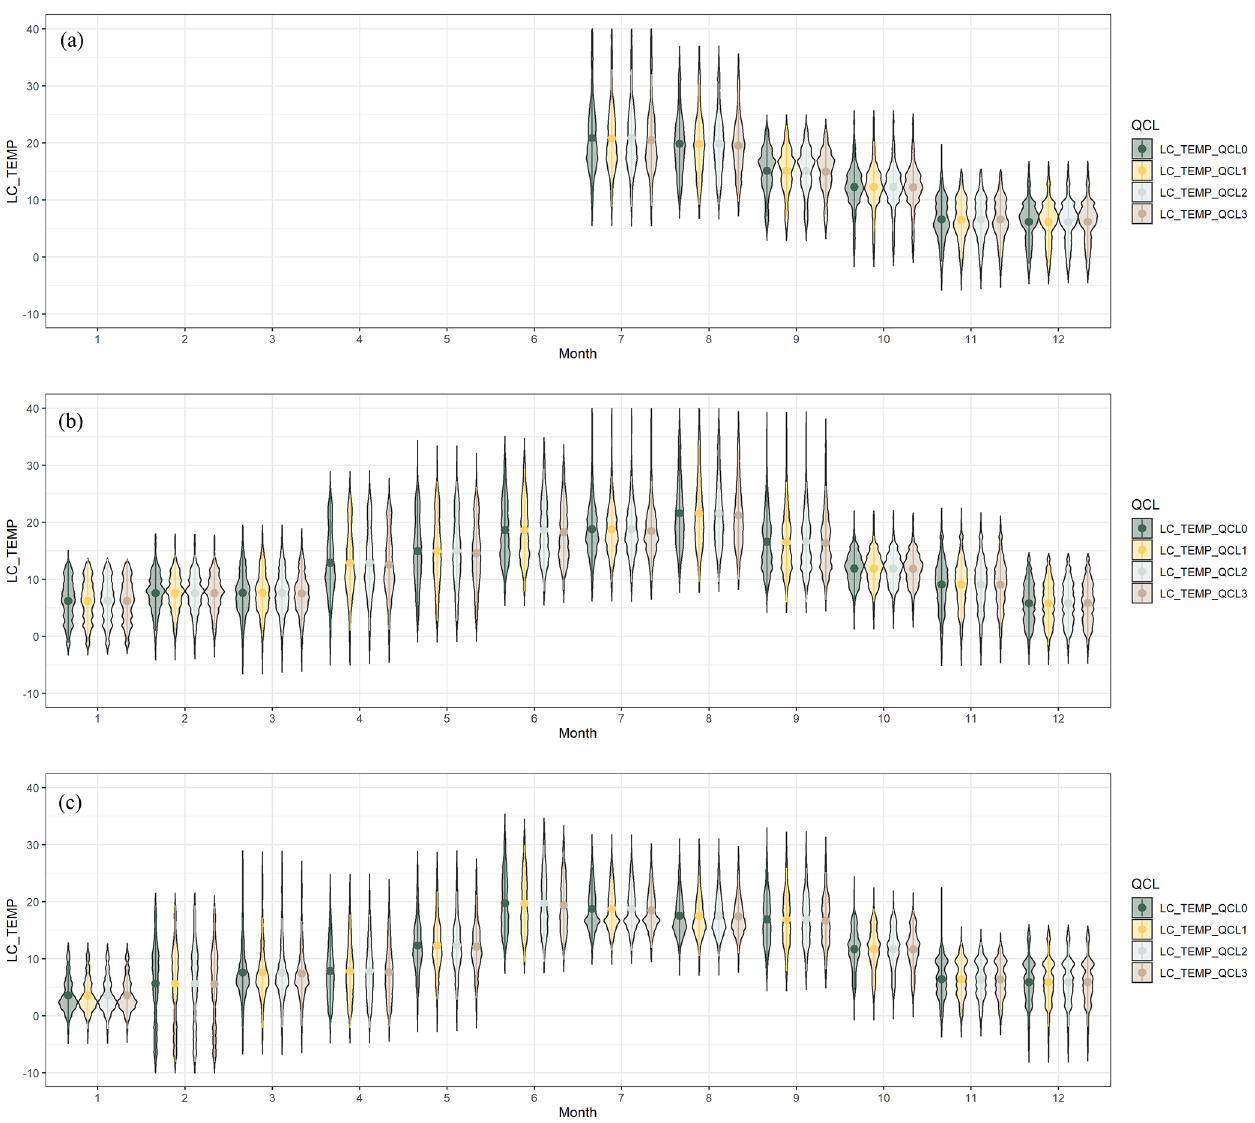
Figure 20. Monthly violin plots of temperature data ( ◦ C) of all LC-X stations at quality control level 0 (raw data), level 1 (outliers removed), level 2 (inter-station bias correction) and level 3 (intra-station bias correction) for 2019 Q3–Q4 (a) , 2020 Q1–Q4 (b) and 2021 Q1–Q4 (c)